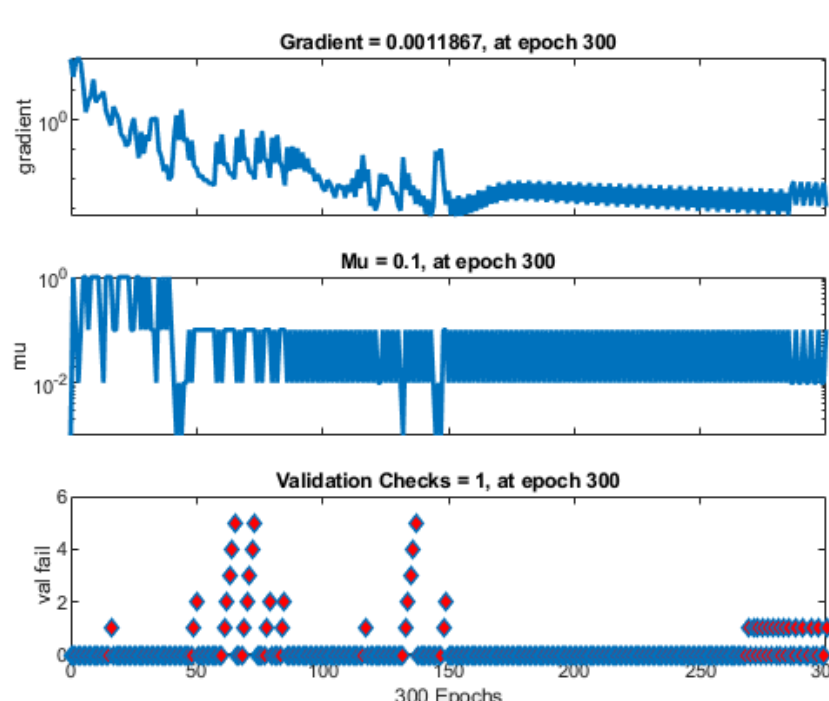
Figure 37. The performance of neural model identification.